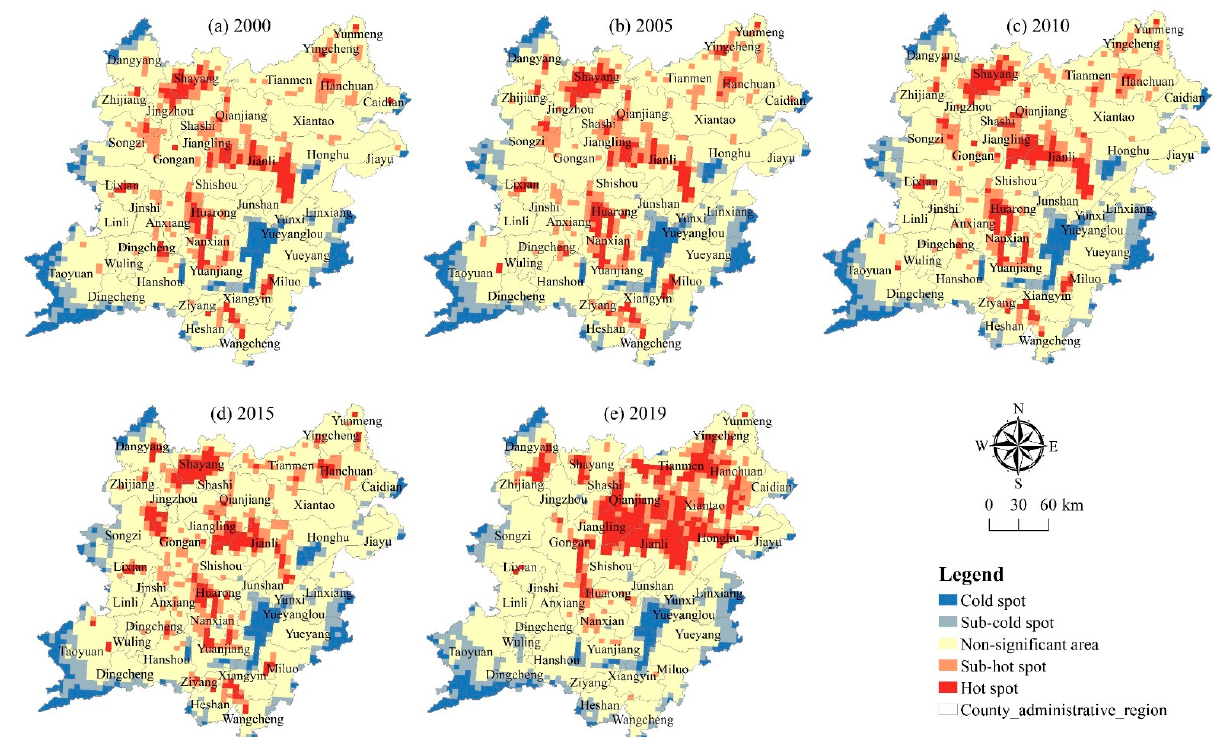
Figure 6. Spatial pattern of cold and hot spots of response index in the two lake plains from 2000 to 2019.